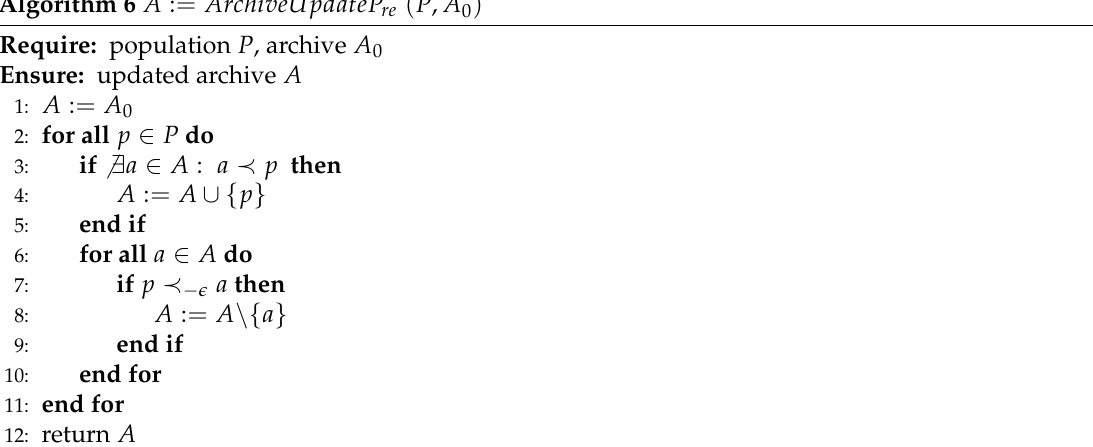
Algorithm 6 A : = ArchiveUpdateP re ( P , A 0